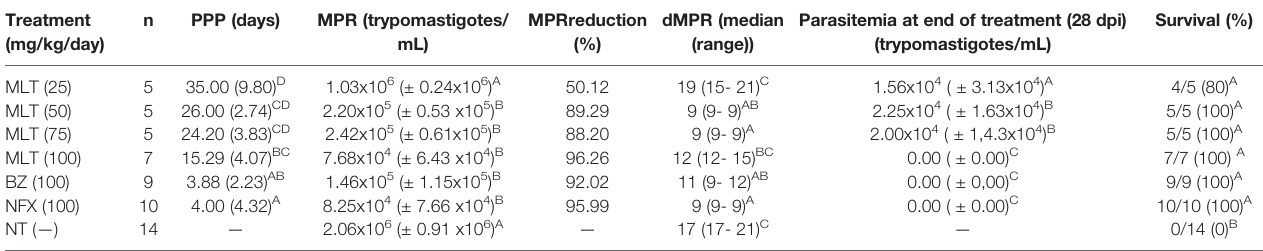
TABLE 1 | Effect of miltefosine, benznidazole, or nifurtimox on parasitemia parameters in BALB/cJ mice infected with Trypanosoma cruzi (VD strain) a . Treatment (mg/kg/day)